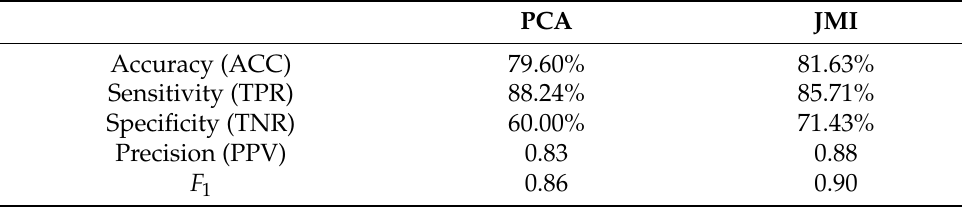
Table 6. Evaluation of the kNN